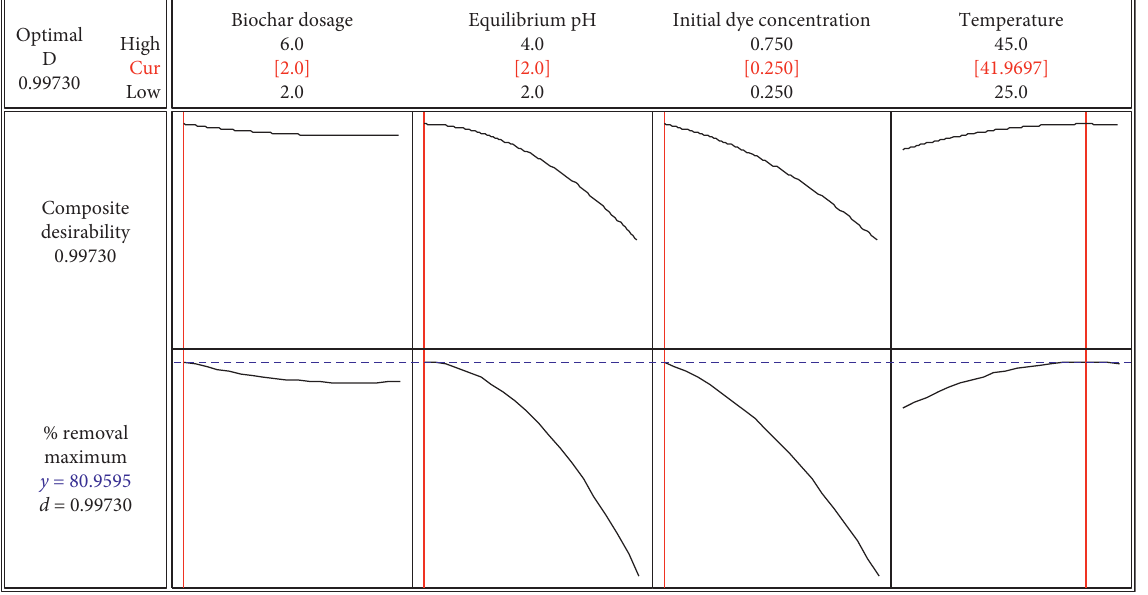
Figure 6: RSM optimizer for enhanced dye removal efficiency.